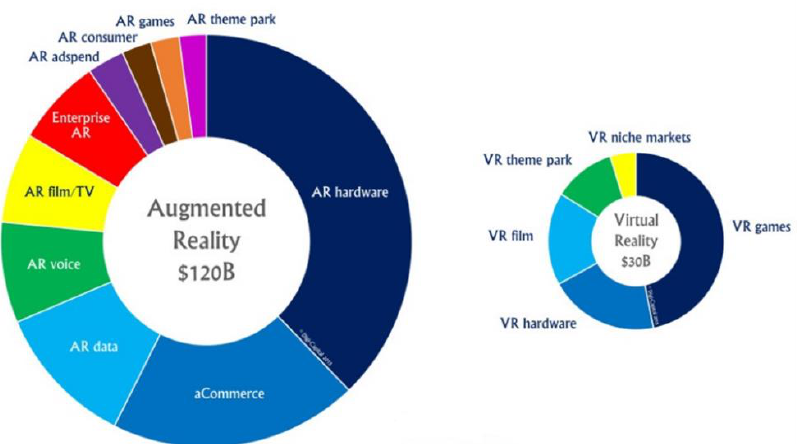
Figure 1. Worldwide Augmented Reality (AR) and Virtual Reality (VR) revenue in 2020 [3].